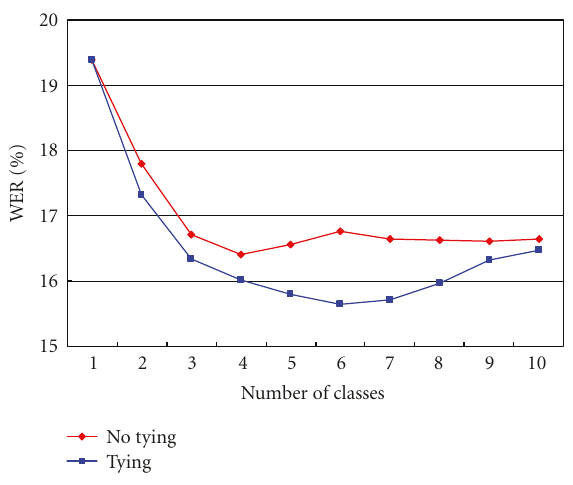
Figure 2: Recognition results of untied/tied class CHEQ compen- sation techniques with regard to various numbers of classes on the Aurora 2 task (clean-condition